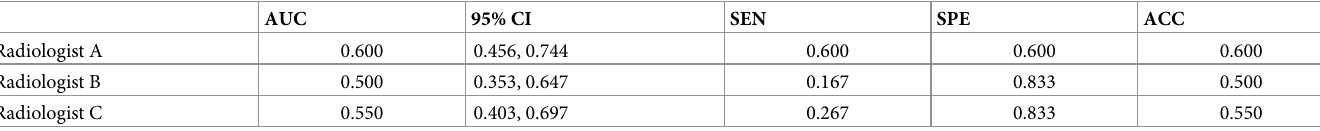
Table 5. The differential diagnosis performance of the radiologists. AUC 95% CI SEN